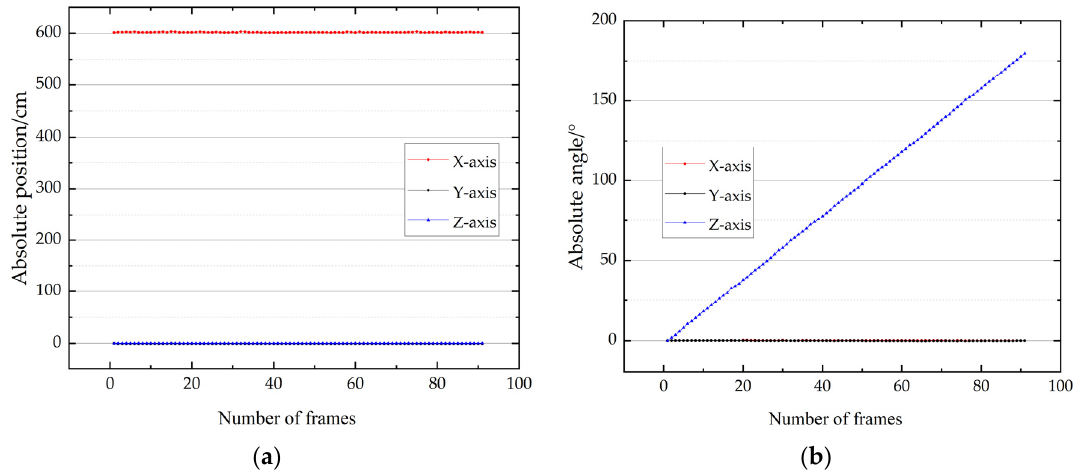
Figure 11. Pose estimation experimental results: ( a ) absolute position; ( b ) absolute angle .